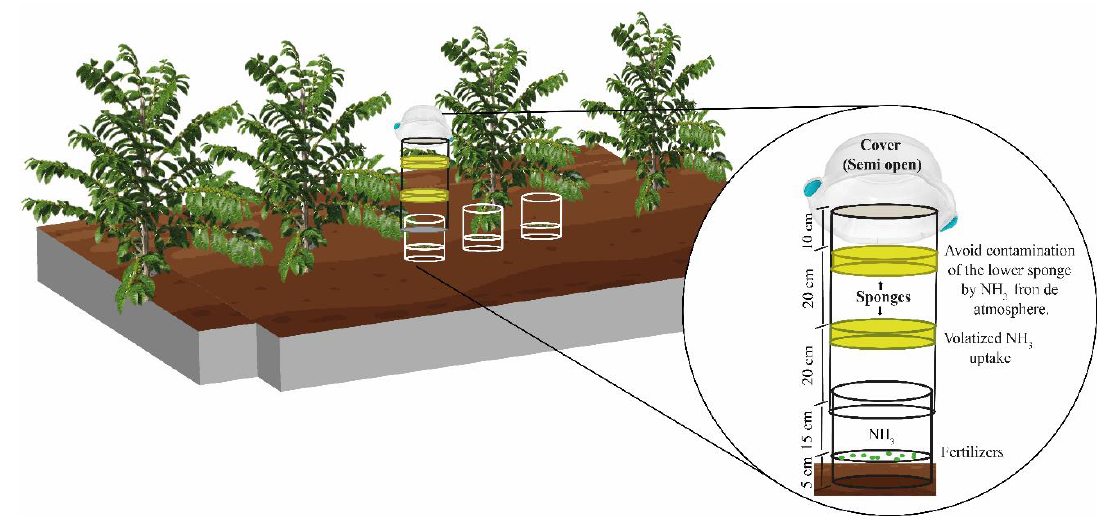
Figure 2. Illustration of the collectors used in the quantification of ammonia losses.